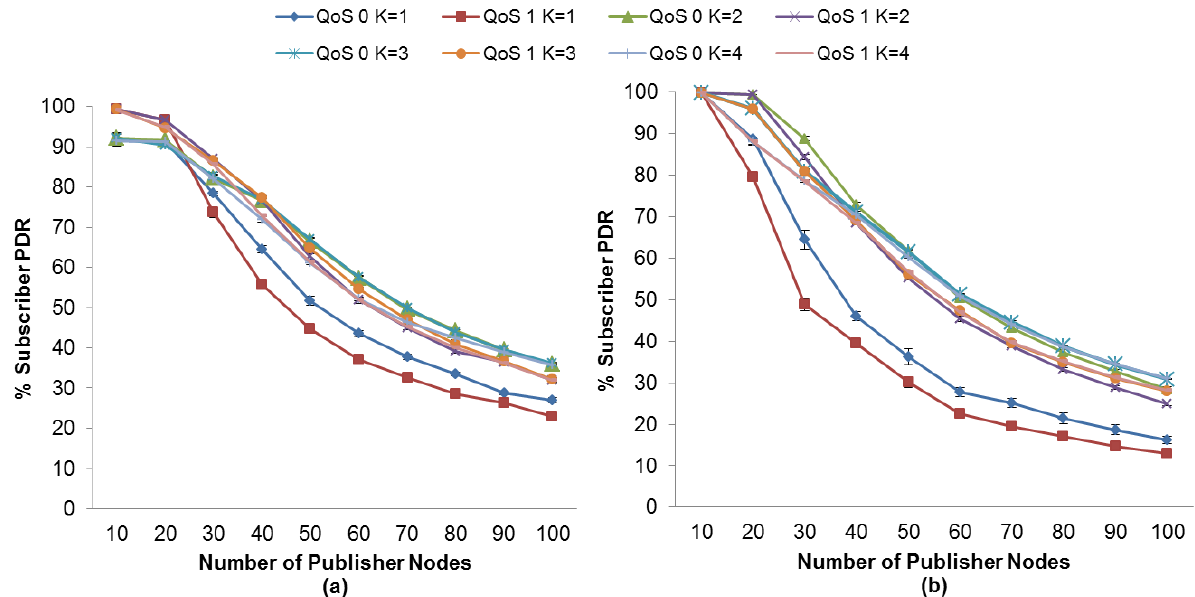
Figure 4. Effect of the number of Publisher Nodes on the Subscribers PDR depending of the K value of RTO with MQTT-S ( a ) without and ( b ) with MAC